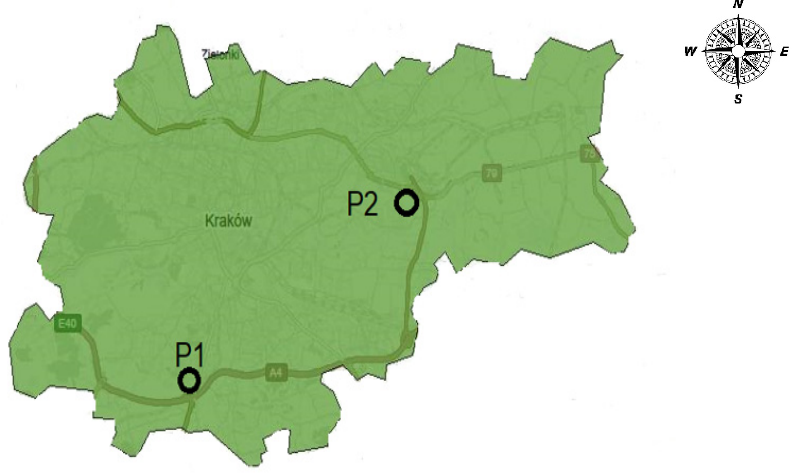
Figure 1. Location of air quality monitoring stations in the Krakow Agglomeration.